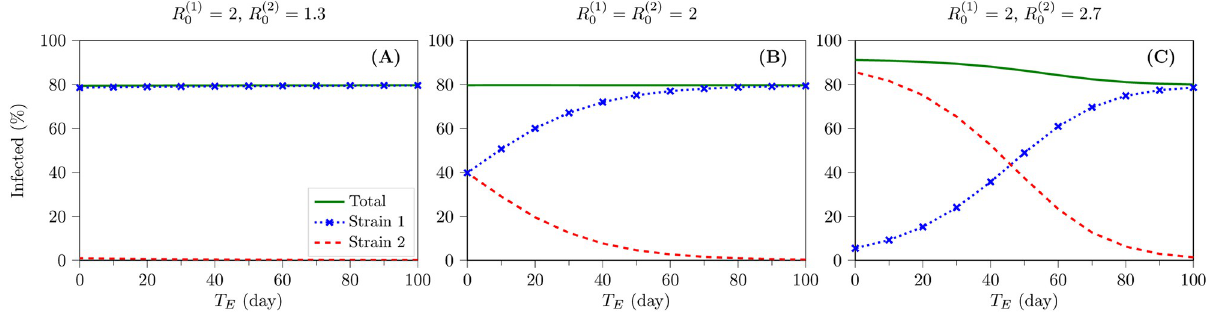
Fig 2. The effect of R ð 1 Þ , R ð 2 Þ , P A , P A , and T on the total number of infected cases in a 2-strain viral epidemic. The fraction of the population who E 0 0 1 2 are infected with strains 1 and 2 and the total percentage of the infected cases are depicted for three cases of R ð 1 Þ R ð 2 Þ 0 (C). Also, these figures demonstrate that the emergence time of the new strain should be considered to determine the winner of the viral competition. In other words, a new, more contingent strain will not be necessarily dominant in the population if it emerges late. The legends of all figures are the same as those in panel